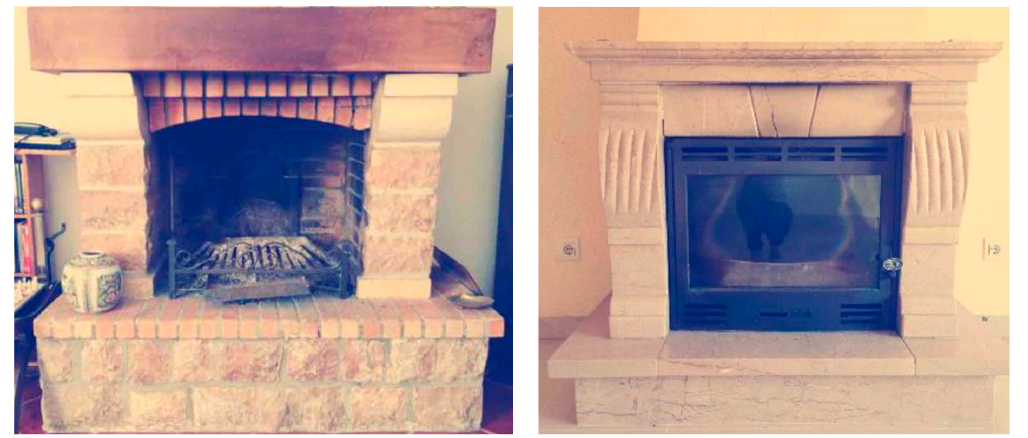
Figure 2. Appliances used for biomass burning include ( left ) an open fireplace located in the living room of dwelling 2 and ( right ) a closed fireplace (insert) located in the living room of dwelling 3. In each device, two biofuel types were combusted using pinewood and briquettes, which were both bought at the local market. According to the producer’s specifications, briquettes were 100% composed of pressed wood with a calorific value of 4800 kcal/kg, 5–7% humidity, and 3% ashes. Each test was conducted on a daily basis with the opening of windows and doors for two hours prior to the experiment in order to promote renovation of the living room indoor air. During the experiments, all doors and windows were closed. A total of 5 kg of each biofuel was burned in one go per experiment. Ashes were removed before the following combustion cycle. For each biofuel and